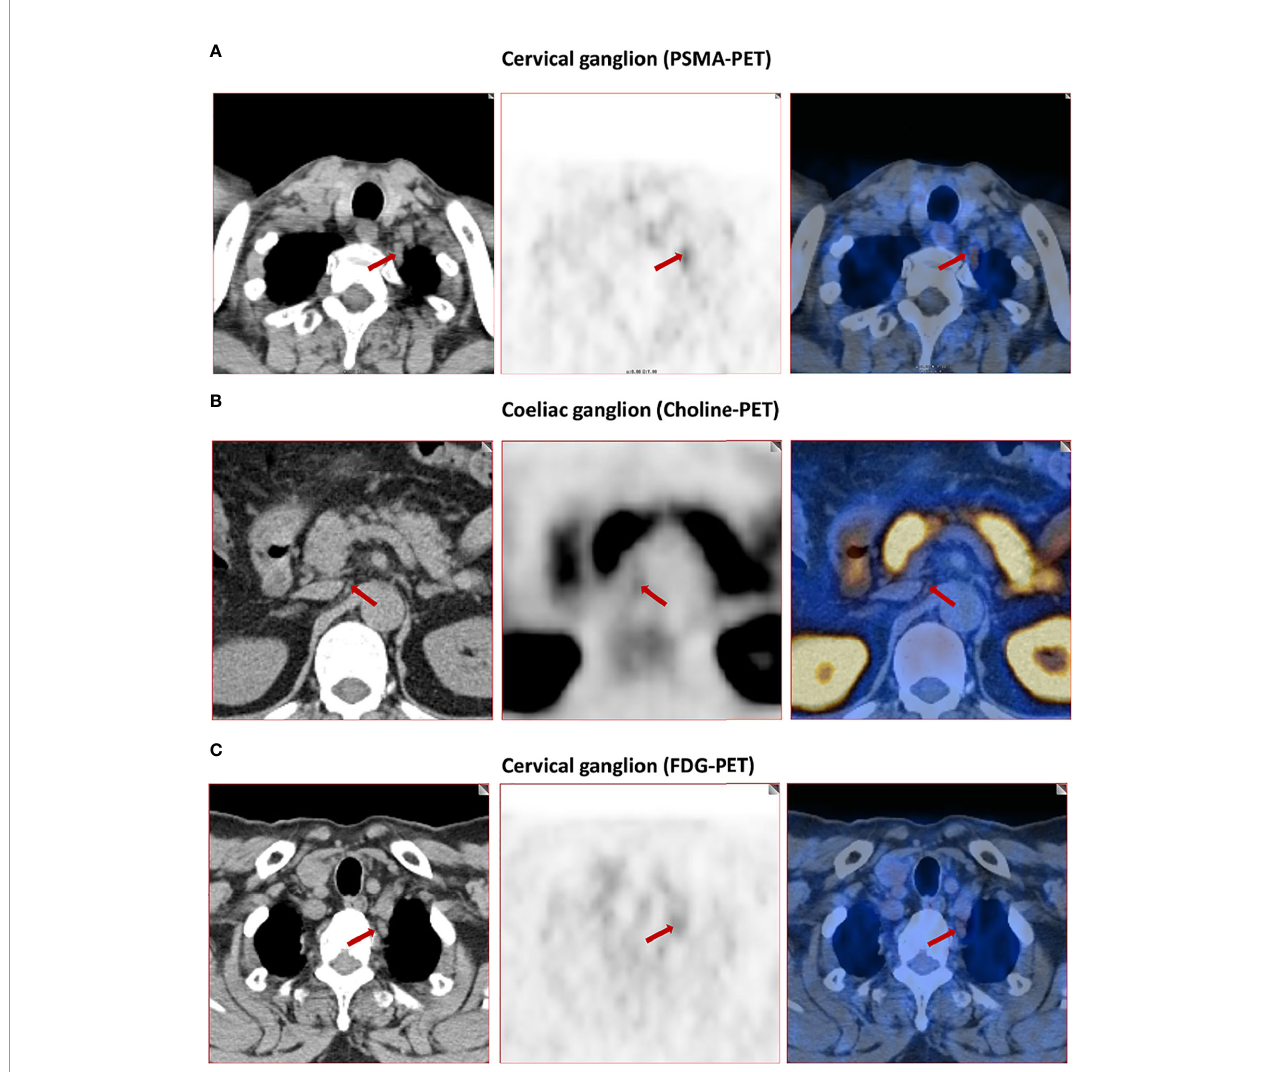
FIGURE 2 | Representative images of PSMA-positive, choline-positive and FDG-positive ganglia. (A) PSMA-positive cervical ganglia (red arrow, 4.8 SUVmax for PSMA-PET). (B) Choline-positive coeliac ganglia (red arrow, 2.8 SUVmax for choline-PET). (C) FDG-positive cervical ganglia (red arrow, 2.9 SUVmax for